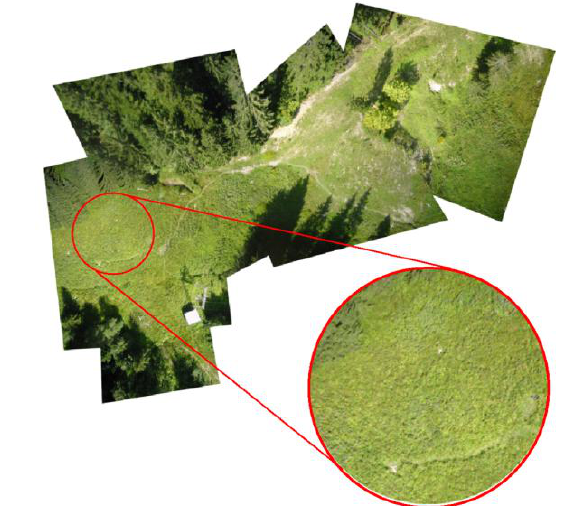
Figure 4. Seamless mosaic of the Heumoes